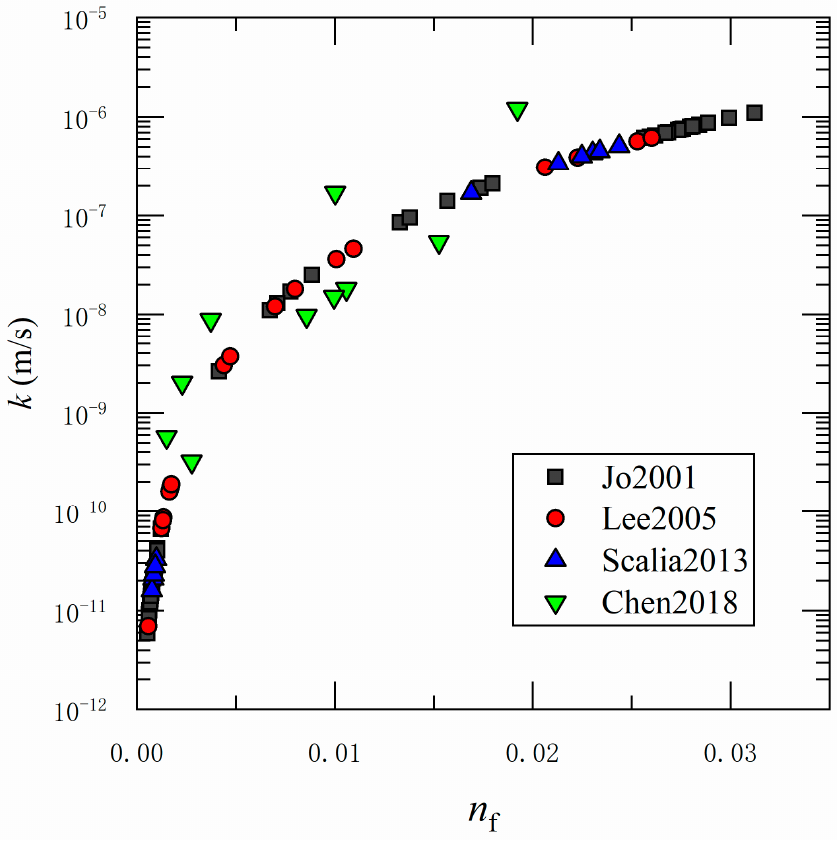
Figure 7. The hydraulic conductivity vs. the mobile porosity.